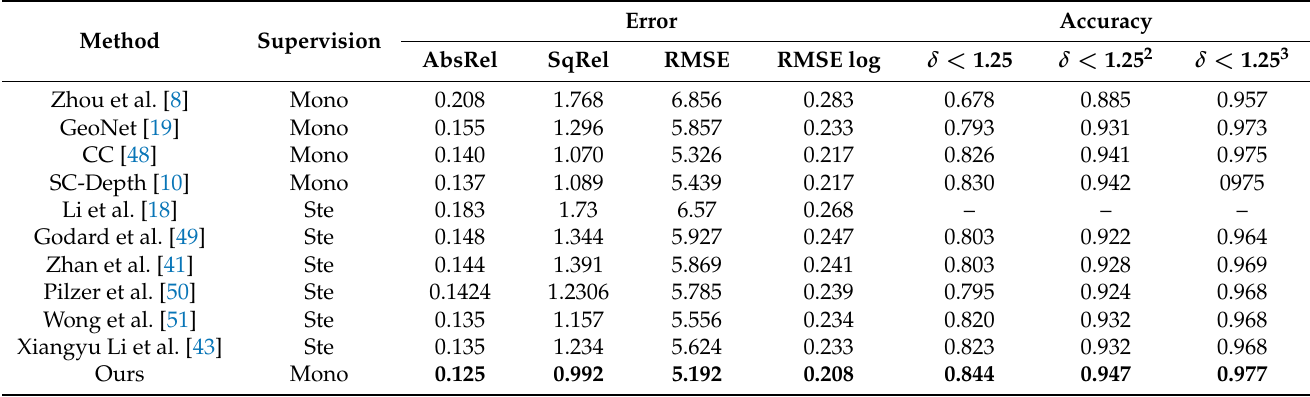
Figure 6. Visual comparison of the estimated depth maps on the KITTI Eigen test set. Our method shows better prediction on objects of different scales, low texture regions and clearly in both close and distant areas. Table 2. Single-view depth estimation results on KITTI odometry split. Mono stands for training on stereo videos, Ste stands for supervised learning using calibrated stereo images. The boldface represents the best result among all